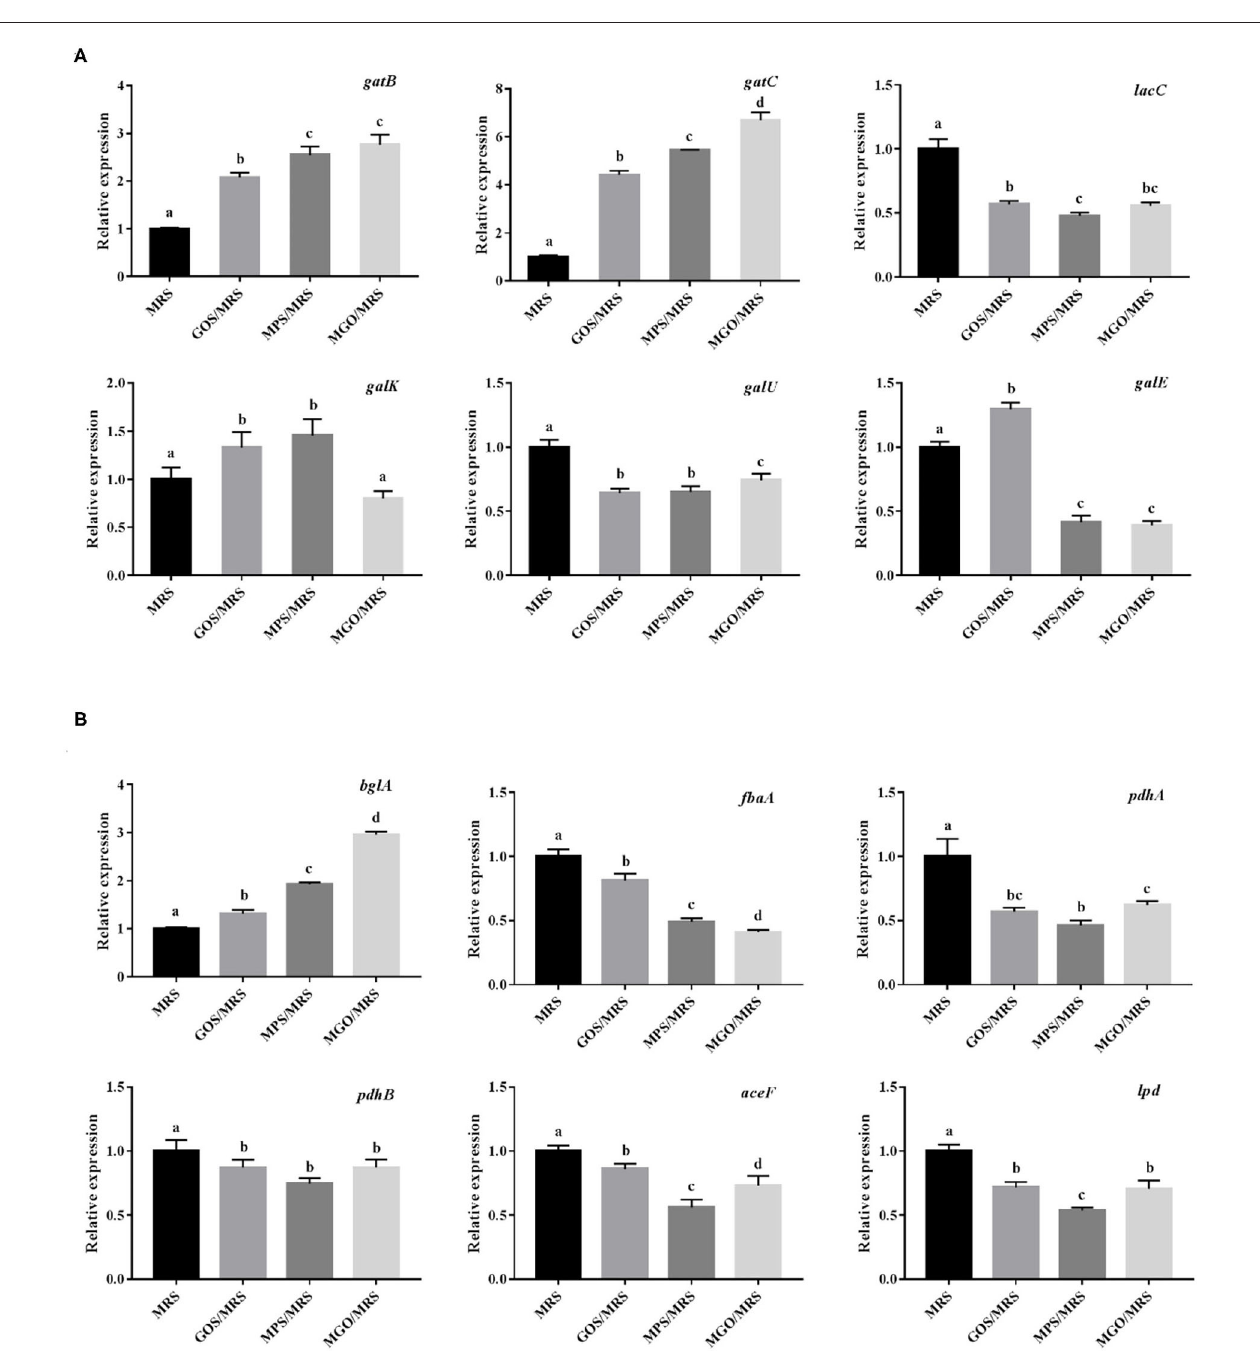
FIGURE 7 | Effects of different prebiotics on the transcription of galactose metabolism pathway-related genes (A) and glycolysis/gluconeogenesis pathway-related genes (B) in LGG cultured for 24h, based on RNA-seq